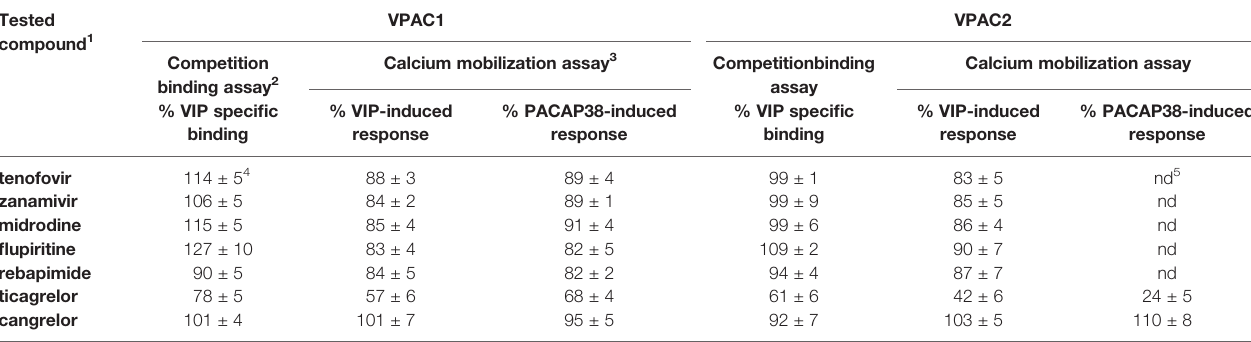
TABLE 2 | Results of binding and functional VPAC1/VPAC2 assays for selected compounds. Tested compound 1